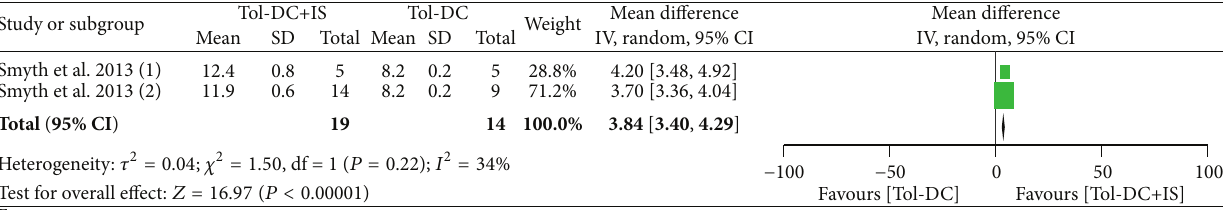
Figure 4: Mean difference (95% confidence intervals) for Tol-DC in combination with IS versus Tol-DC alone for allografts survival in heart (a), islet (b), and skin (c) transplantation models. In the footnotes, “ − ” before “DC” means genetic modification and “+” inside the parentheses means substances added in the culture medium and “+” outside the parentheses means combined IS agents. If not specialized, DC refers to donor bone borrow